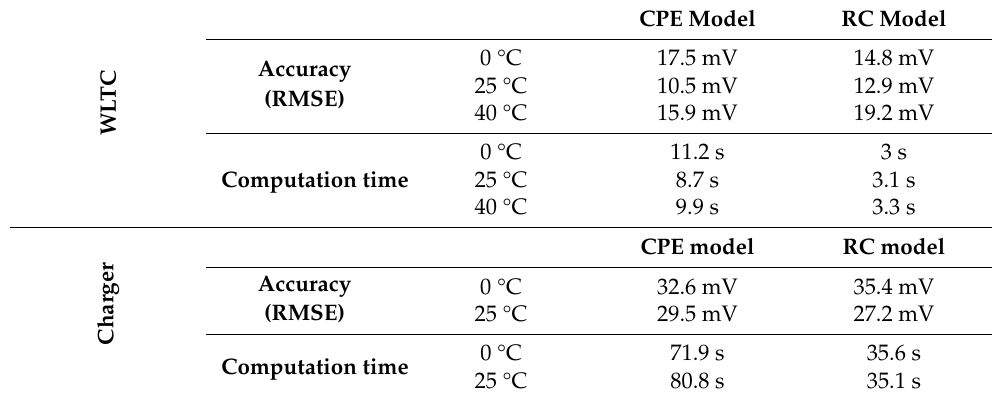
Table 4. Accuracy and computation time for different temperatures using the mobile charging station and WLTC